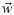
A scatterplot of the data shown in Fig 10.Each row-trace shown on the left in Fig 10 is plotted as a single point in 2-dimensional space; the horizontal-axis corresponds to the maximum row-trace and the vertical-axis corresponds to the average row-trace (taken across the iterations). The original-data is indicated with a ‘⊗’, and each of the random shuffles with a colored ‘•’. The p-value for any point w→ in this plane is equal to the fraction of label-shuffled-traces that have either an x-position larger than xw or a y-position larger than yw, where xw and yw are the x- and y-percentiles associated with the most extreme coordinate of w→ (details given in section A14.2) of S2 Text. Each random shuffle is colored by its p-value determined by the label-shuffled-distribution. By comparing the original-trace with the shuffled-distribution we can read off a p-value for the original-data of ≲ 0.008.